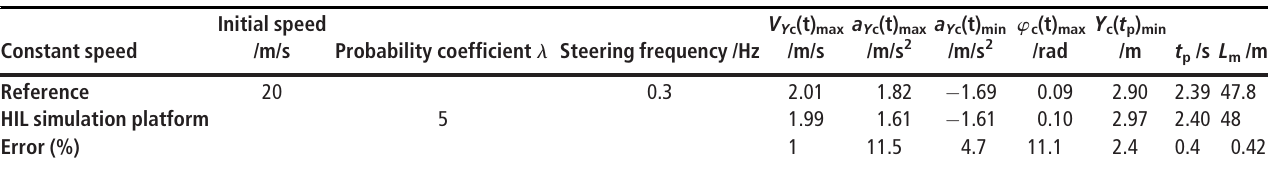
Table 5 Effect veri fi cation of